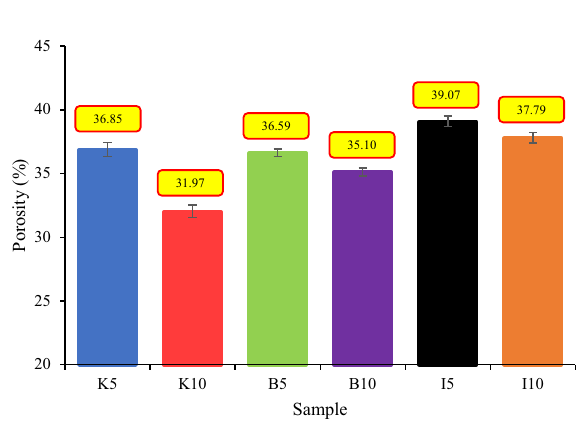
Figure 4. Porosity of samples.